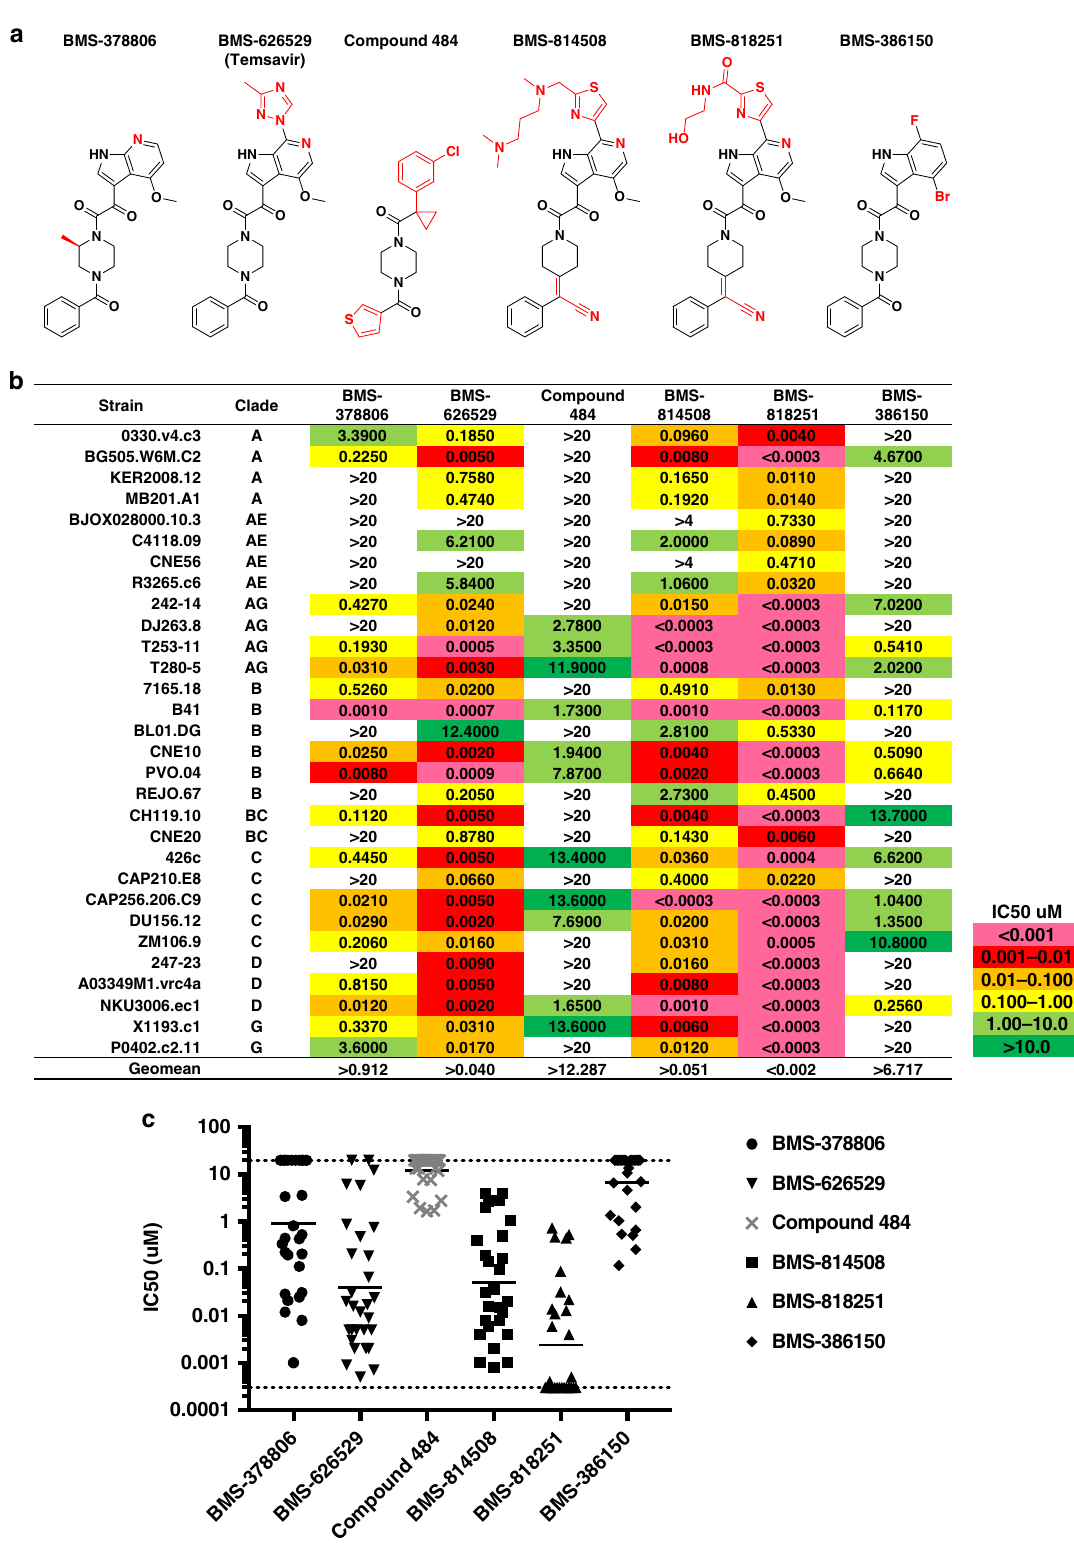
Fig. 1 Diverse HIV-1 entry inhibitors span >6000-fold differences in neutralization potency, with BMS-818251 being >20-fold more potent than BMS-626529 (temasvir). a HIV-1 entry inhibitors with common functional groups shown in black and unique features in red. b Neutralization assay of entry inhibitors against thirty HIV-1 isolates from all major HIV-1 clades. c Neutralization data shown as a scatter plot, with the geometric mean shown as horizontal bars. Dotted lines show the detection limits of neutralization